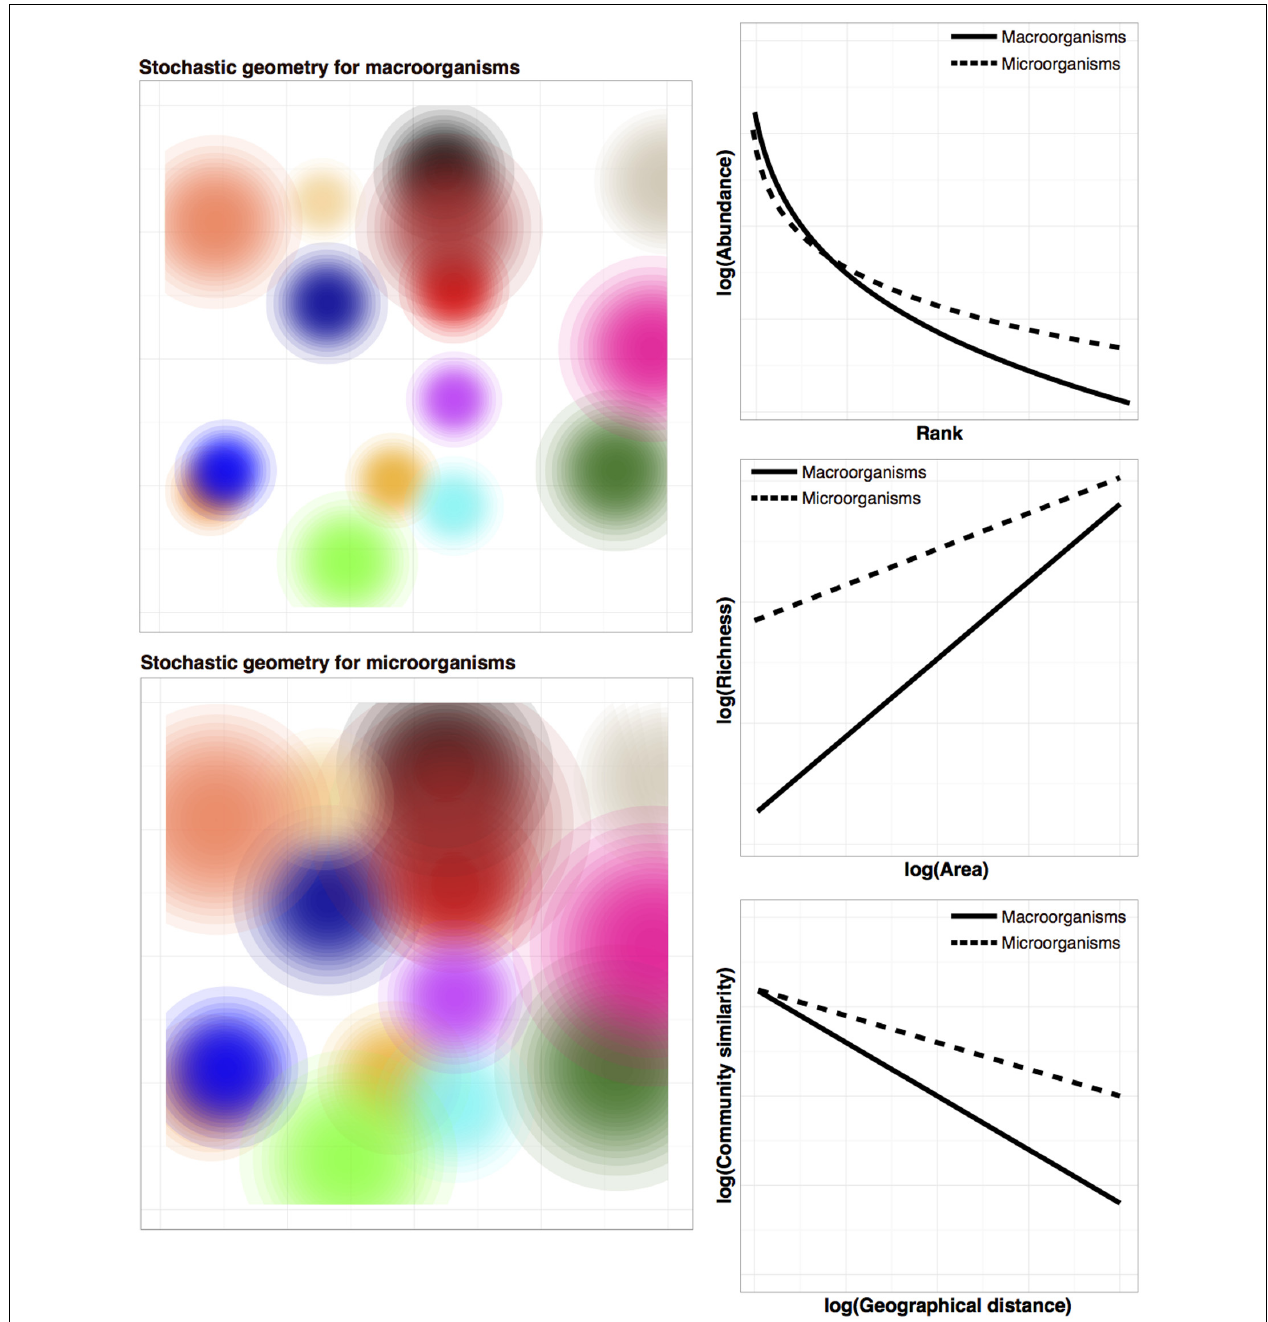
sampling areas of the same size at different distances. The tendency of microorganisms to be better dispersers (larger spatial distributions) is sufficient to reproduce the observed qualitative differences of macroecological patterns between macroorganisms and microorganisms. For microbes, the key differences observed for microorganisms versus macroorganisms include: richer species abundance distributions with longer tails of rare taxa (Curtis etal., 2006), species-area relationships with a higher total number of species and with lower slopes (Lennon and Jones, 2011), and a more moderate decay of community similarity with distance (Soininen, 2012). That is, microbial communities would tend to have a higher number of species (richness, or alpha-diversity) but lower turnover